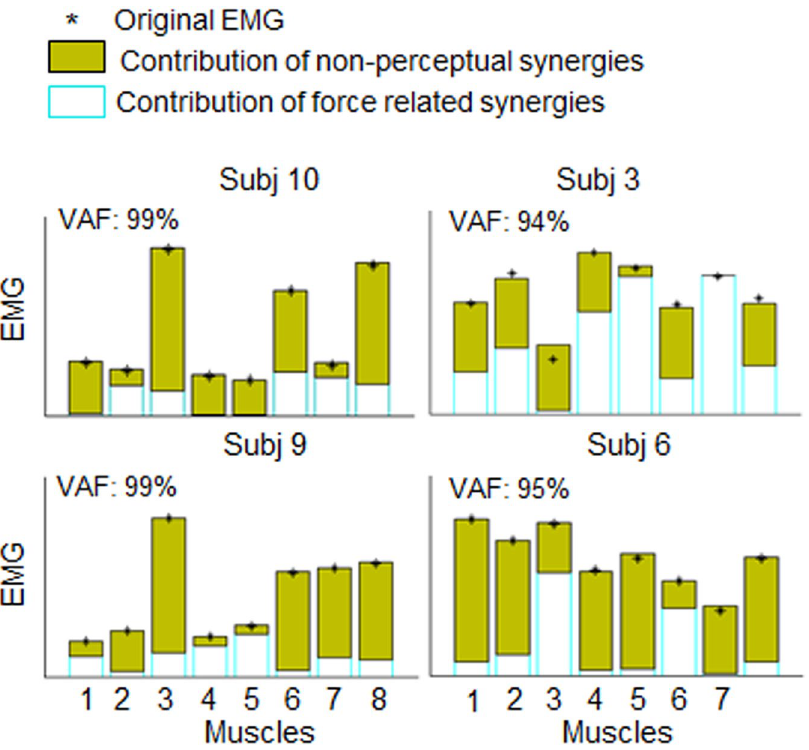
Figure 6. Contribution of synergy subsets to EMG dataset reconstruction. Perceptual (cyan empty bars) and non-perceptual (filled green bars) synergy subset contribution to the reconstruction of the original EMG activity (VAF) of each muscle calculated (4 representative participants; for data from the remaining participants see Fig. S6, Supplementary Material). Asterisks denote original EMG from each muscle. VAF values refer to the global variance accounted for by the group of task-related muscle synergy, namely when perceptual and non- perceptual synergies subsets were merged for EMG reconstruction. Muscles numbering is the same as in Fig. 2.